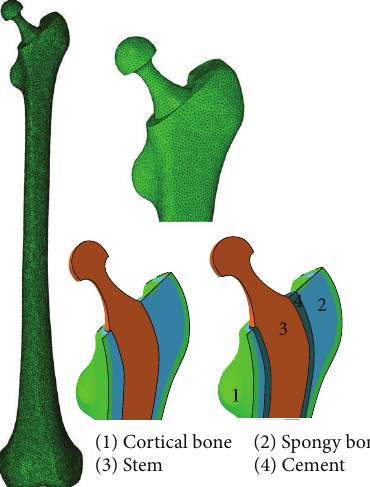
Figure 1: The implanted femur model.